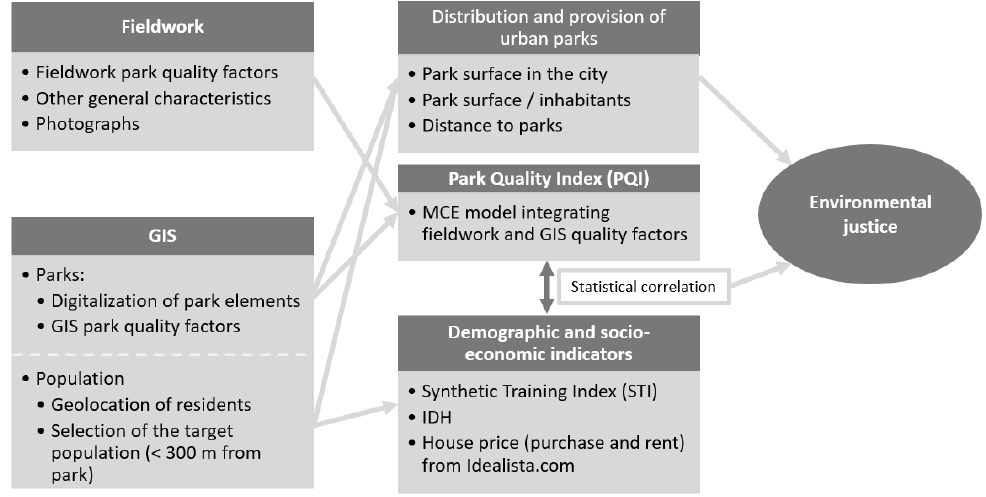
Figure 2. Methodological process .